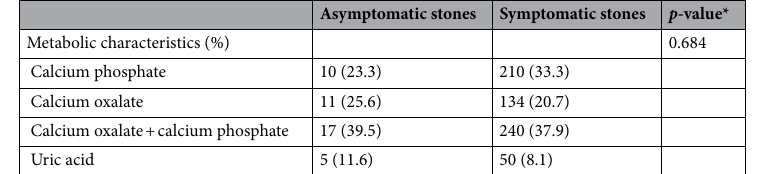
Table 3. Metabolic characteristics of stones. *Fisher’s exact